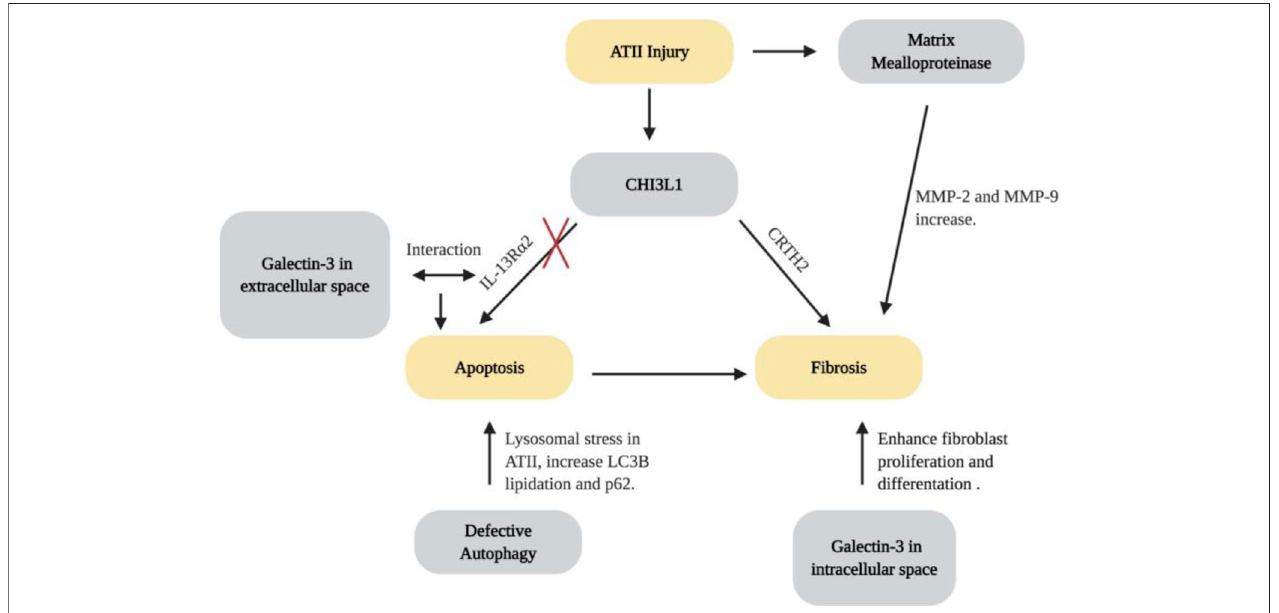
FIGURE 3 | Molecular pathways for the development of lung fi brosis in HPS. Created with